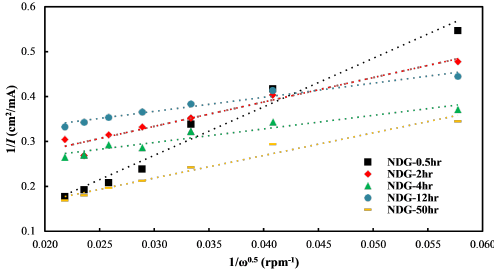
Fig. 10. K-L plot of all